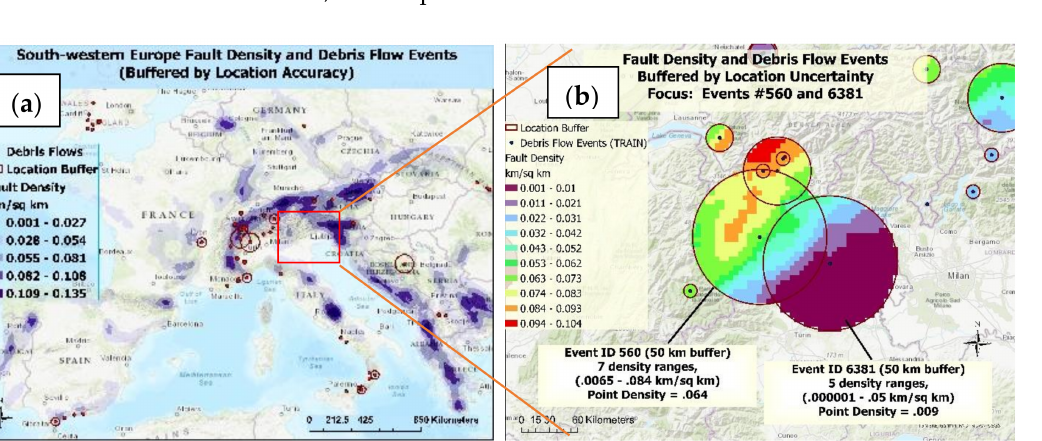
Figure 3. Fault density (km/sq km) overlay and debris flow event locational uncertainty buffers. ( a ) Fault densities in western Europe. ( b ) Fault density (Natural Break (Jenks) classification— 10 breaks) and debris flow event locational uncertainty buffers, highlighting events 560 and 6381, both with 50 km location uncertainties. Base maps and imagery are from ArcGIS ® , the intellectual property of Esri, used herein under license. Copyright©